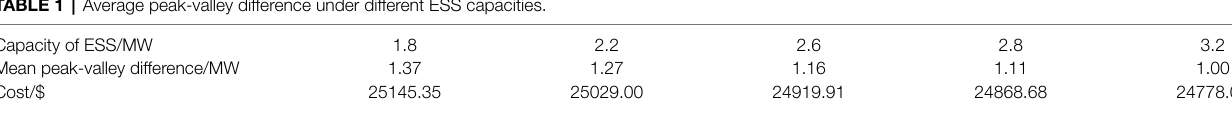
TABLE 1 | Average peak-valley difference under different ESS